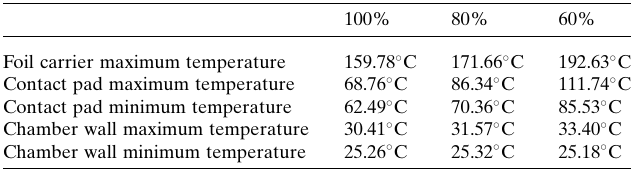
Table 4 Foil carrier, contact pad and chamber wall temperatures for different contact area